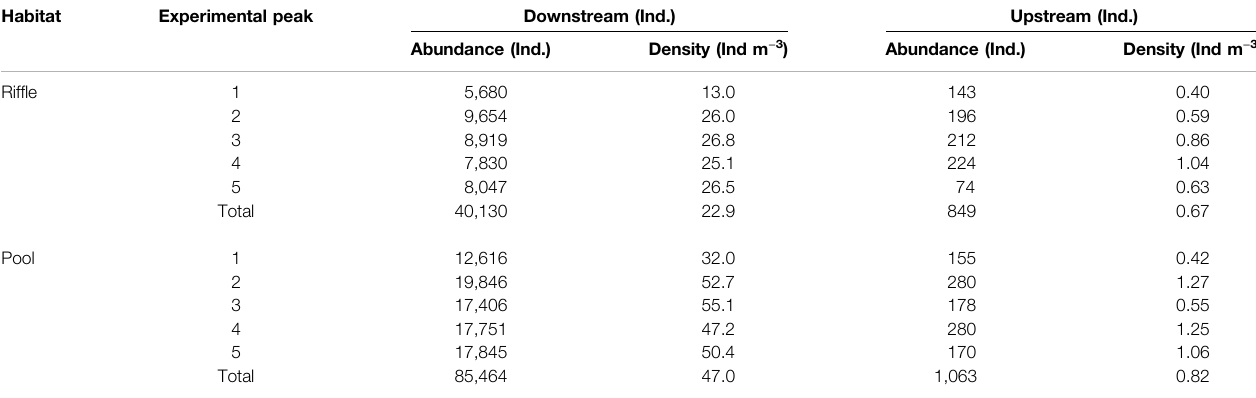
TABLE 3 | Abundance and drift density observed at the fi ve experimental peaks in the two habitats at the downstream and upstream measurements site.